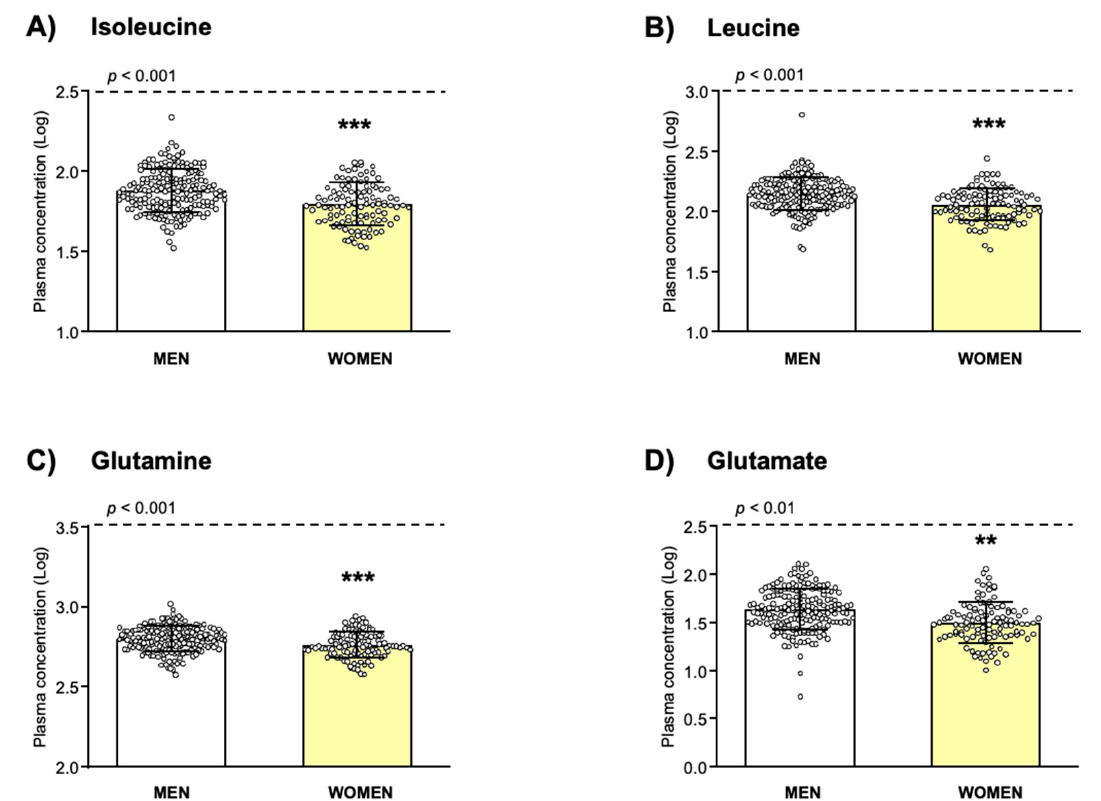
Figure 1. Plasma amino acid concentrations in relation to sex in the total sample. ( A ) L-Isoleucine; ( B ) L-Leucine; ( C ) L-Glutamine; ( D ) L-Glutamate. Dots are individual values. Bars are estimated marginal means and 95% CI of log 10 -transformed amino acid concentrations in men and women. Data were analyzed by two-way ANCOVA controlling for age and BMI. (**) p < 0.010 and (***) p < 0.001 denote significant differences compared with men.